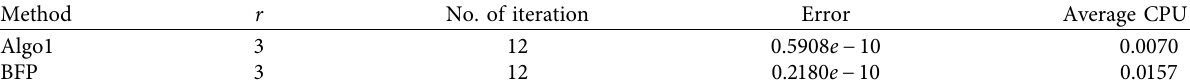
Table 1: Comparison of Algorithm 1 with basic fixed point iteration.